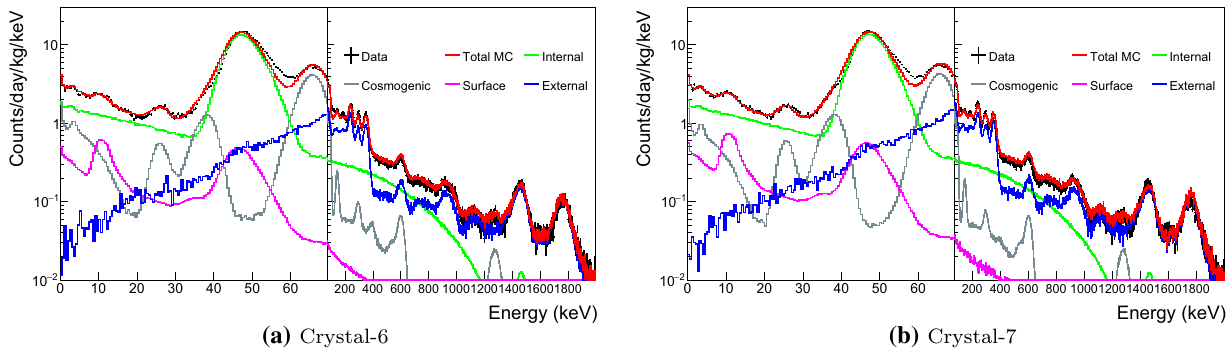
Fig. 6 Measured single-hit background spectra of Crystal-6 and Crystal-7 fitted with all simulated background